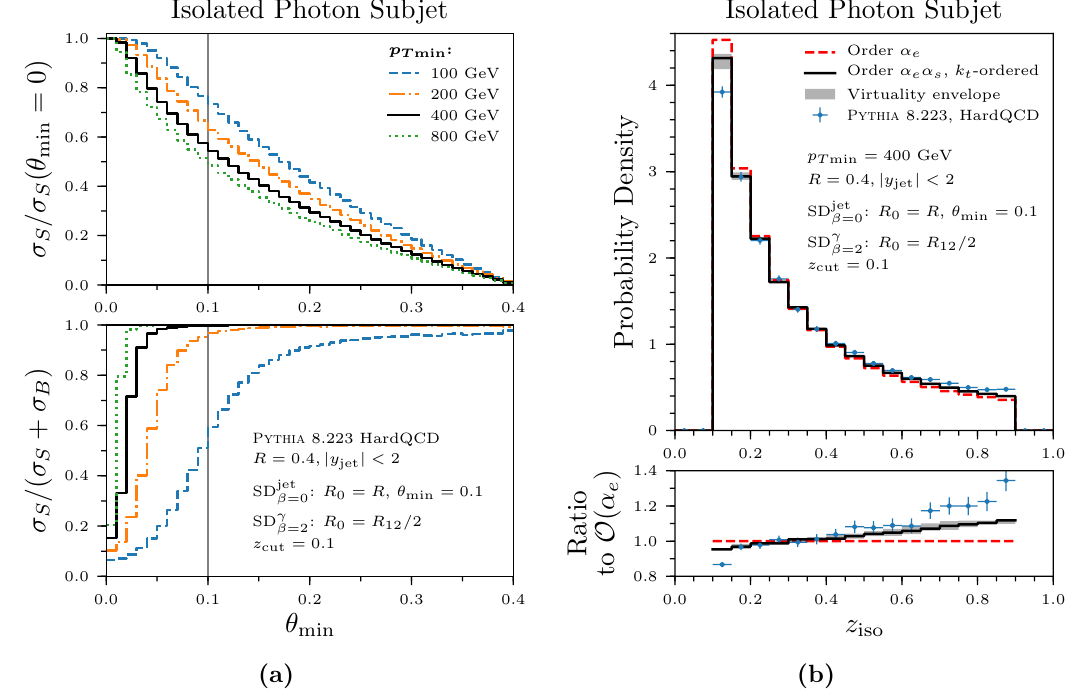
Figure 6. (a) Top: Pythia cross sections of the q q(cid:13) signal as a function of (cid:18) min , given ! as a ratio to the cross section at (cid:18) min = 0. The signal also decreases with p T , and we found (cid:27) S ( (cid:18) min = 0) = 1000 ; 96 ; 6 : 2 ; 0 : 22 pb at p T min = 100 ; 200 ; 400 ; 800 GeV. This background does f g f g not include backgrounds from \fake" photons from collinear (cid:25) 0 (cid:13)(cid:13) decays. Bottom: ratio of the ! signal cross section to the sum of signal and background cross sections. (b) Probability distributions of z iso for the isolated photon subjet at order (cid:11) e , order (cid:11) e (cid:11) s , and in Pythia with p T min = 400 GeV and (cid:18) min = 0 :